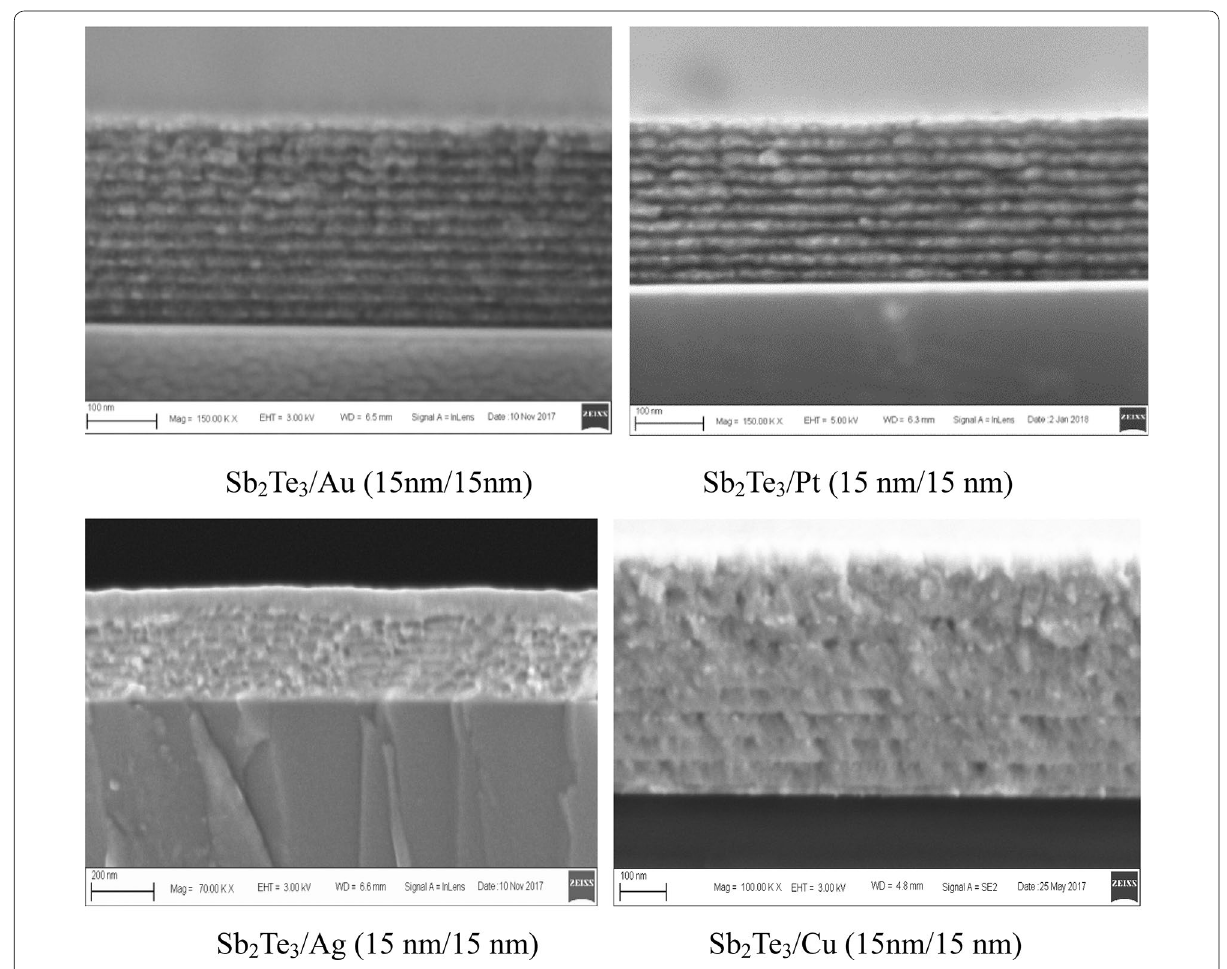
Fig. 1 Comparison of the cross plane morphology of multilayer thin films with the same period thickness